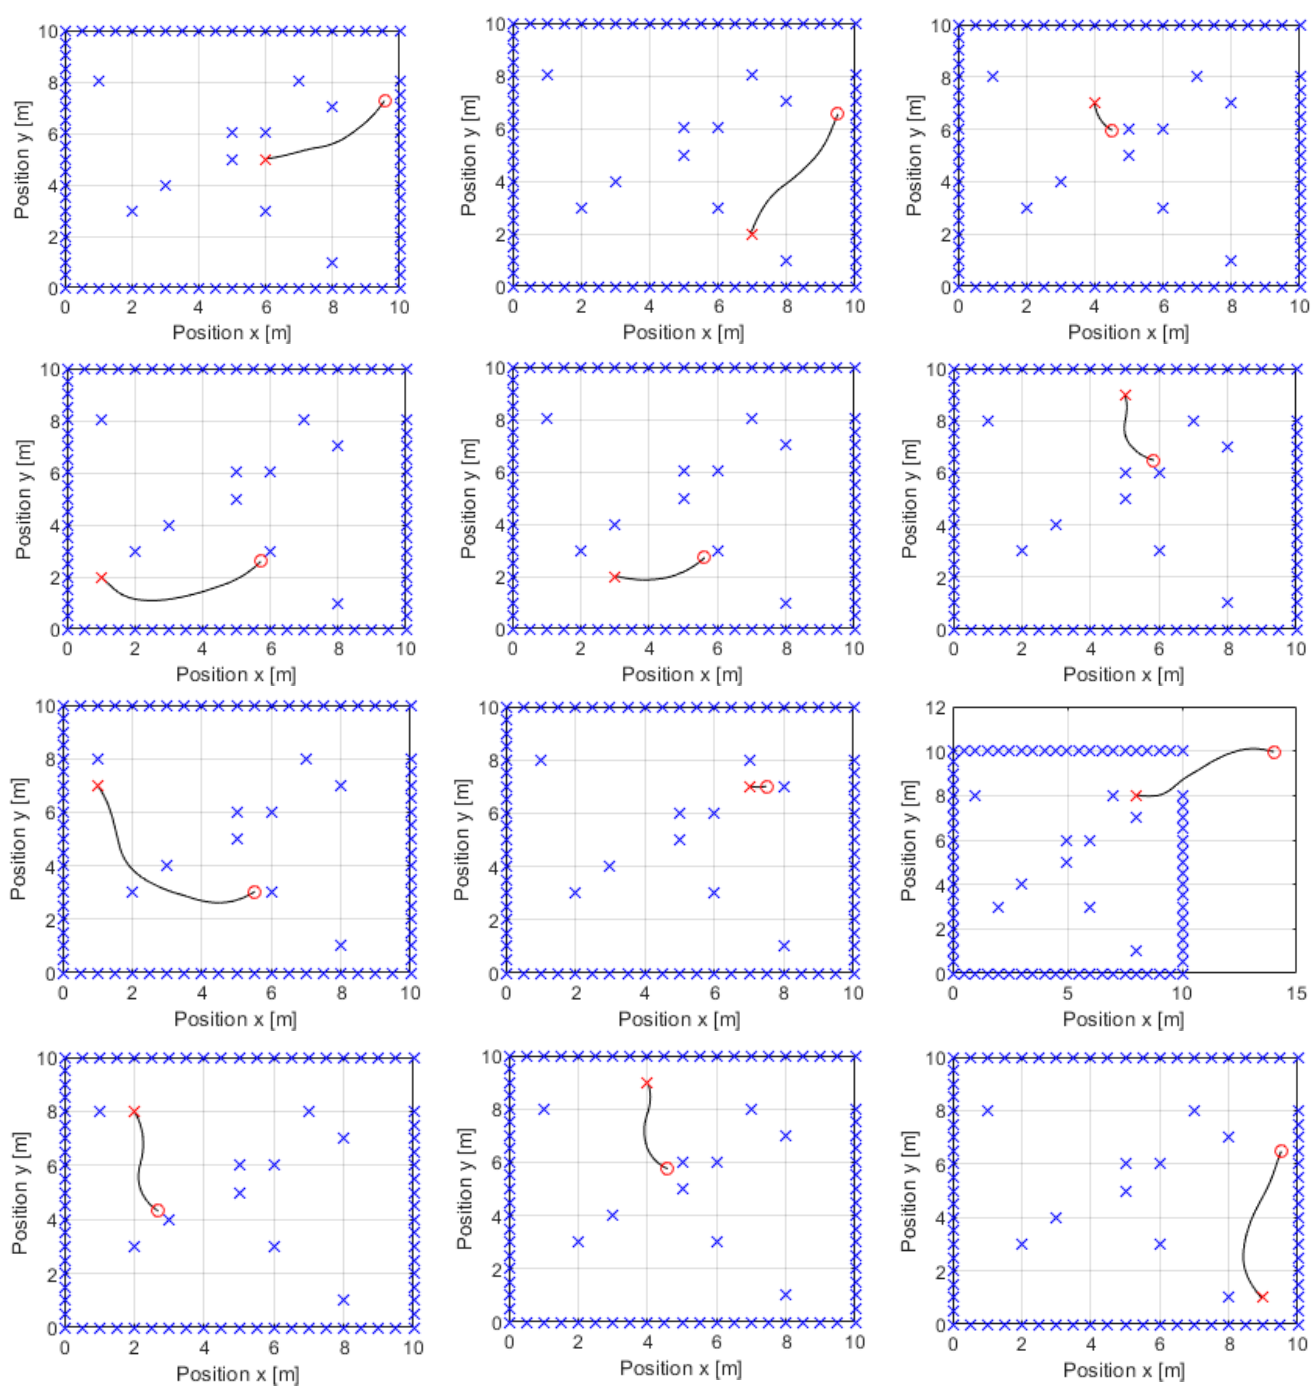
Figure 9. Different trajectories generated by Agent K, starting the navigation from different origins.